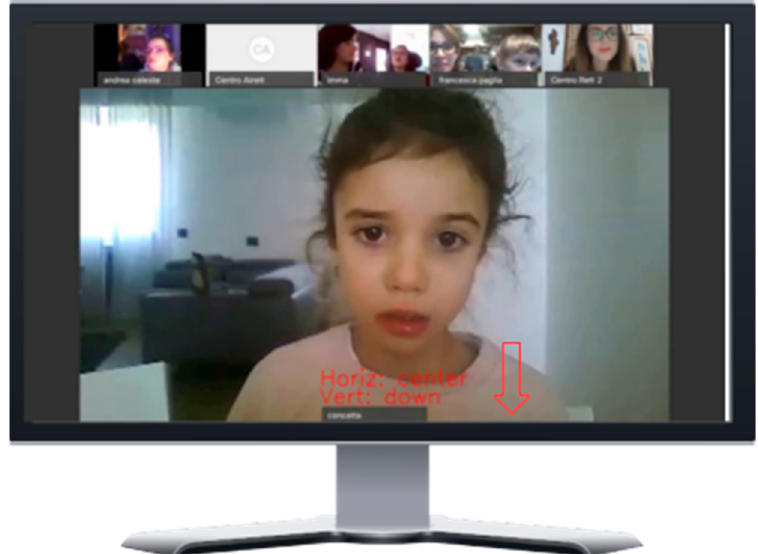
Figure 5. The Visualization Module showing the output of SWYG.